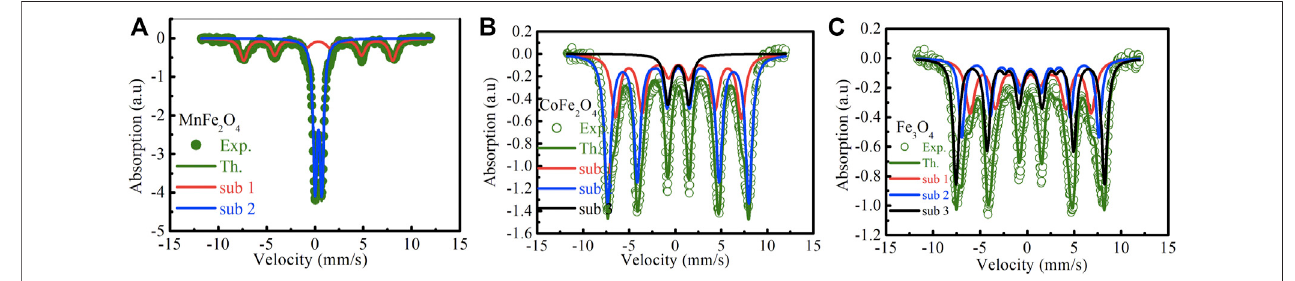
FIGURE 4 | Mossbauer spectra at room temperature of (A) MnFe 2 O 4 , (B) CoFe 2 O 4 and (C) Fe 3 O 4 nanoparticle in the as-dried condition.